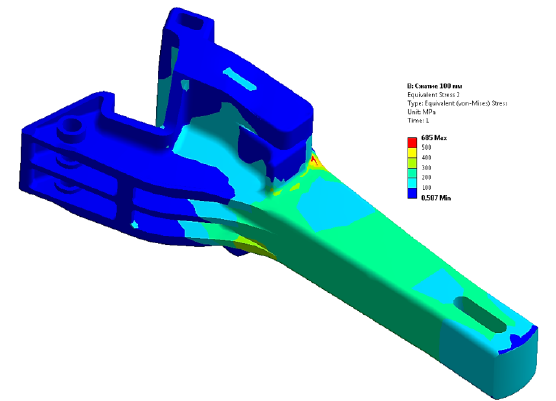
Figure 1. Equivalent stress distribution field, compression, displacement of the axis of an adjacent automatic coupling 0.1 m below the considered, MPa